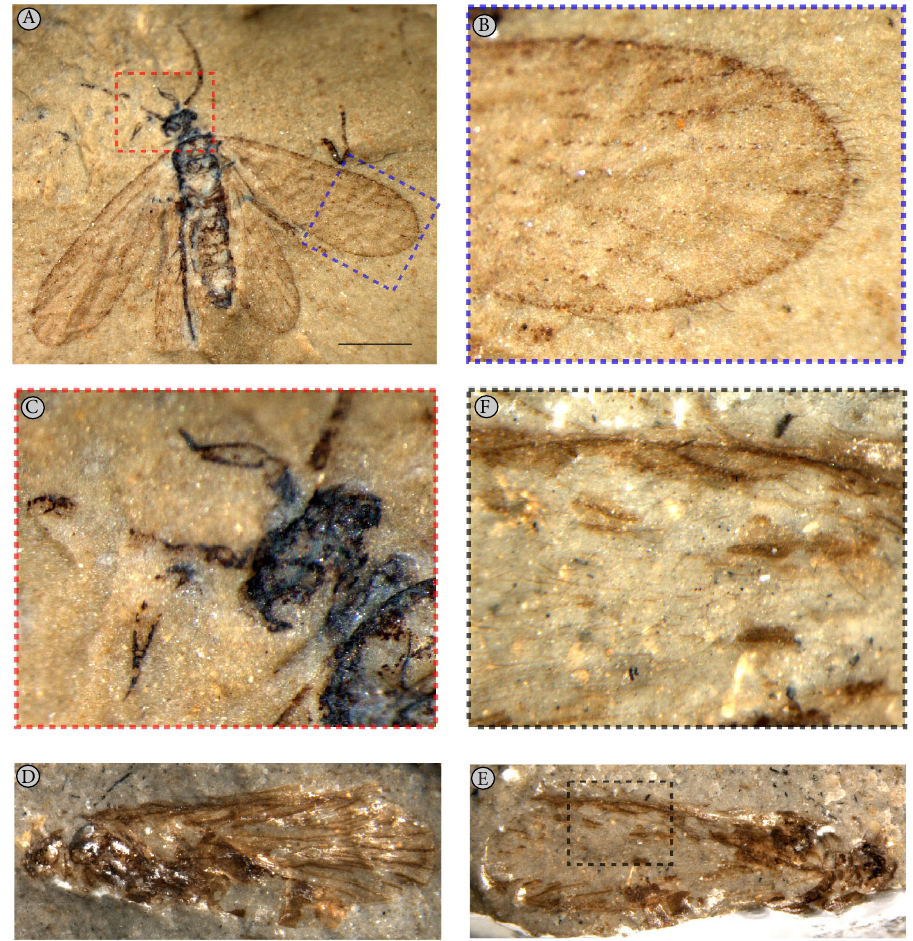
Figure 2: Two examples of necrotauliid wings with hairs and labial palps: (a) Necrotaulius tener Sukatsheva, 1990 from Daya, Russia (PIN 3015/819); (b) hairs; (c) labial palps; (d) Austaulius furcatus (NHMUK II 3104 a); (e) counterpart NHMUK II 3104 b; (f) hairs on NHMUK II 3104 b